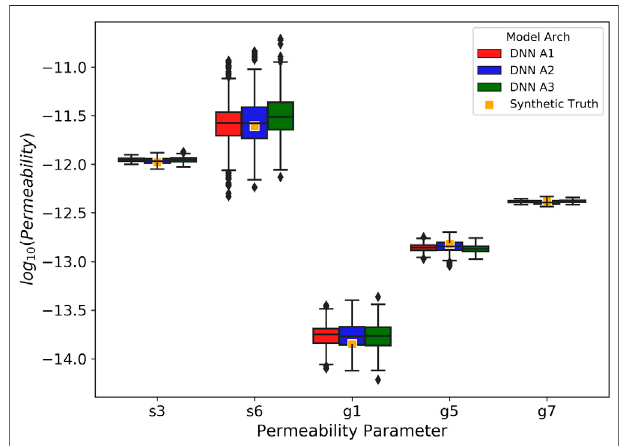
FIGURE 7 | Sensitivity of model types to noise added to the simulated discharge for ensemble 537. The boxplots represent the distribution of the log 10 estimated permeability value from the 100 noisy discharge vectors. The yellow square dot are the synthetic permeability values for the simulation (ensemble